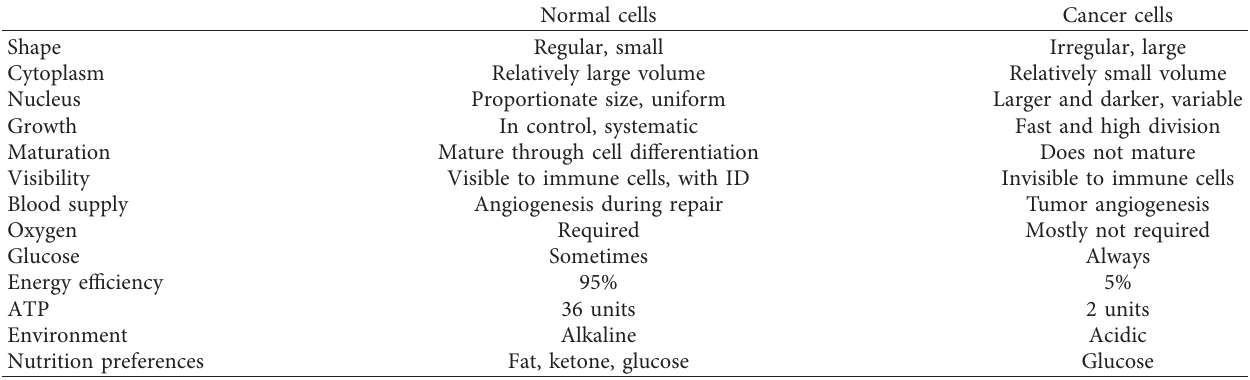
Table 1: Biological properties of normal and cancer